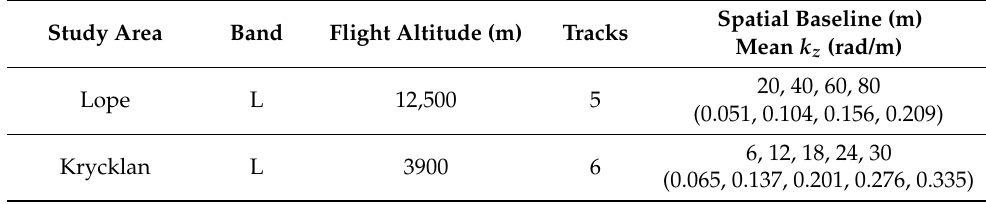
Table 1. Configuration of airborne SAR in the experimental area. Study Area Band Flight Altitude (m)